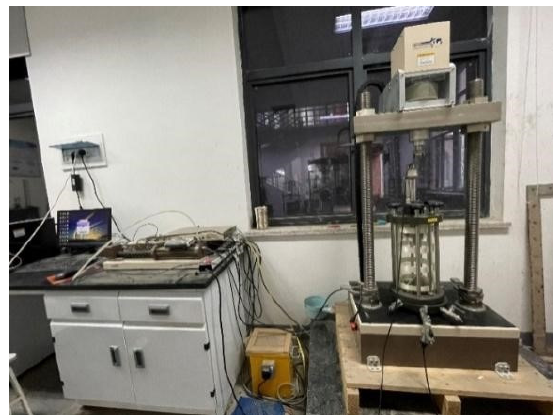
Figure 1. GDS Triaxial Testing System.